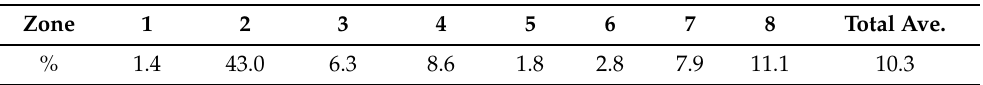
Table 3. Porosity for the eight representative zones after the corrosion test on EUROFER in a water solution buffered with 500 ppm of NH 3